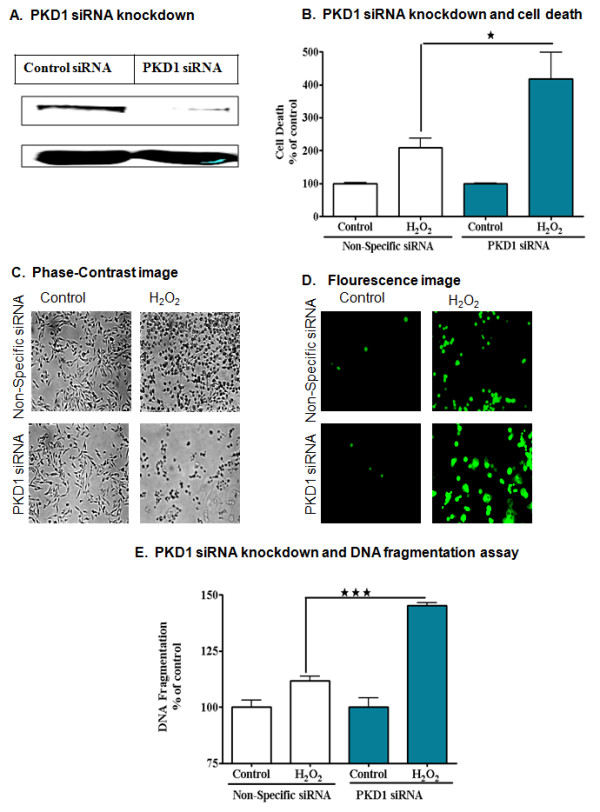
PKD1 has a cell survival function during oxidative stress in dopaminergic neuronal cells. N27 dopaminergic cells were transfected with 1 μM PKD1 siRNA and non-specific siRNA (A) and treated with 100 μM H2O2 for 120 minutes and monitored for cytotoxicity using Sytox green dye. Fluorescence measurements for the incorporation of Sytox green read using a flourescence plate reader (B) and visualised by phase contrast and fluorescence microscopy (C&D). DNA fragmentation assay (E) showed increased cytotoxicity and apoptosis in PKD1 knocked down samples exposed to H2O2. *, p < 0.05 and ***, p < 0.001 denote significant difference between Non-Specific siRNA- H2O2 and PKD1 siRNA-H2O2 treated groups.